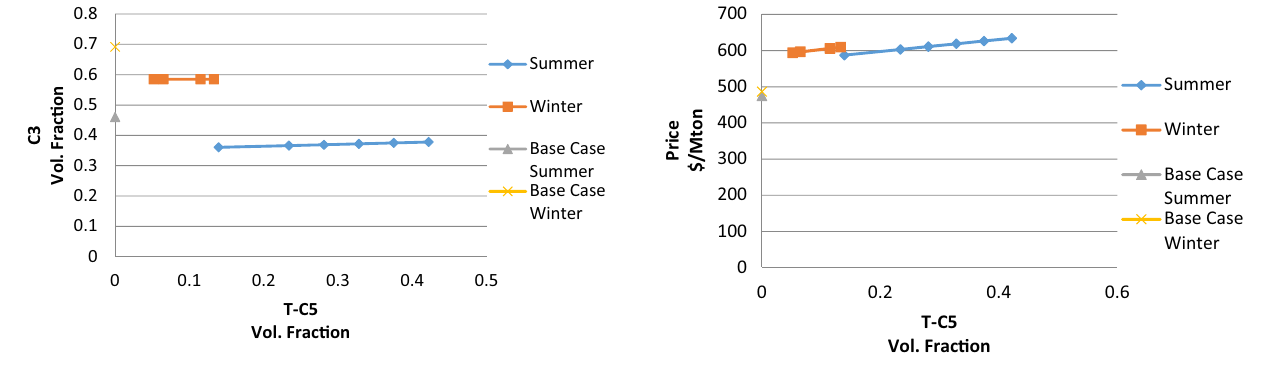
Fig. 43 Effect of adding i-C5, 2,2DMP and 20 vol% DME on